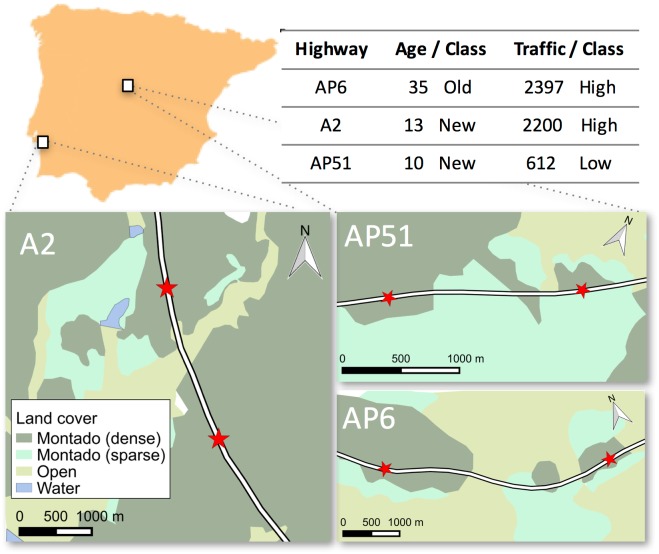
Location of the studied highways (white rectangles) in the Iberian Peninsula, land cover surrounding the study sites (red stars), and classification of the highways according to their age and traffic volume.Land cover was classified based on aerial photographs from Google Maps (accessed on December 1, 2015). Dense/sparse montado (oak woodlands) distinguishes between ‘high’ (>30%) and ‘low’ (<30%) tree cover (authors’ observation). Traffic volume is the number of vehicles passing between 2000 and 0600 h, as the wood mouse is a crepuscular species.